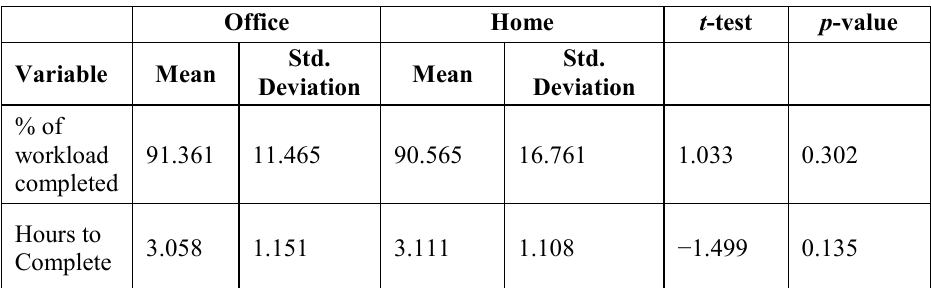
Table 2. Paired Sample Comparison for Working